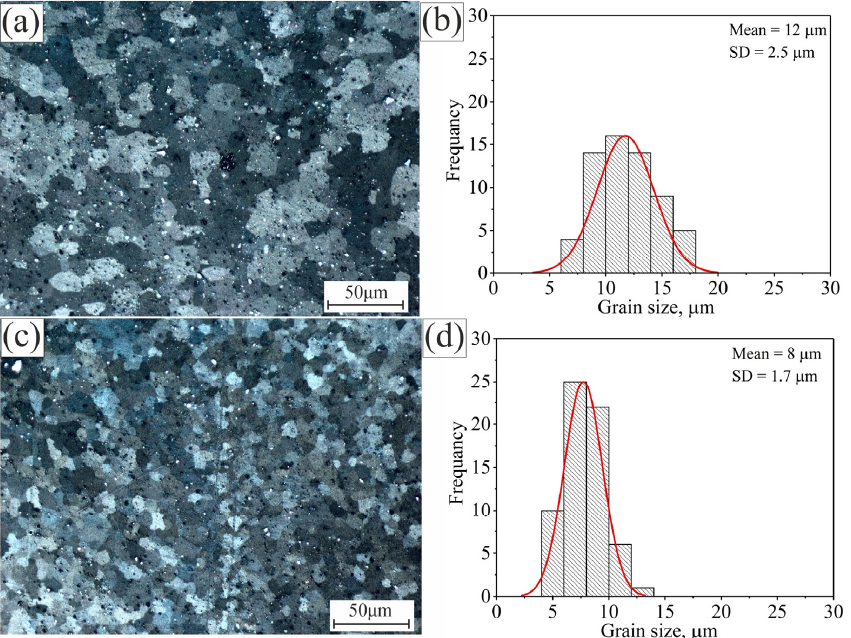
Figure 5. The microstructure and the grain size distribution after second pass of the investigated alloys: ( a , b ) Al 5052 and ( c , d ) Al 5052/TiB.